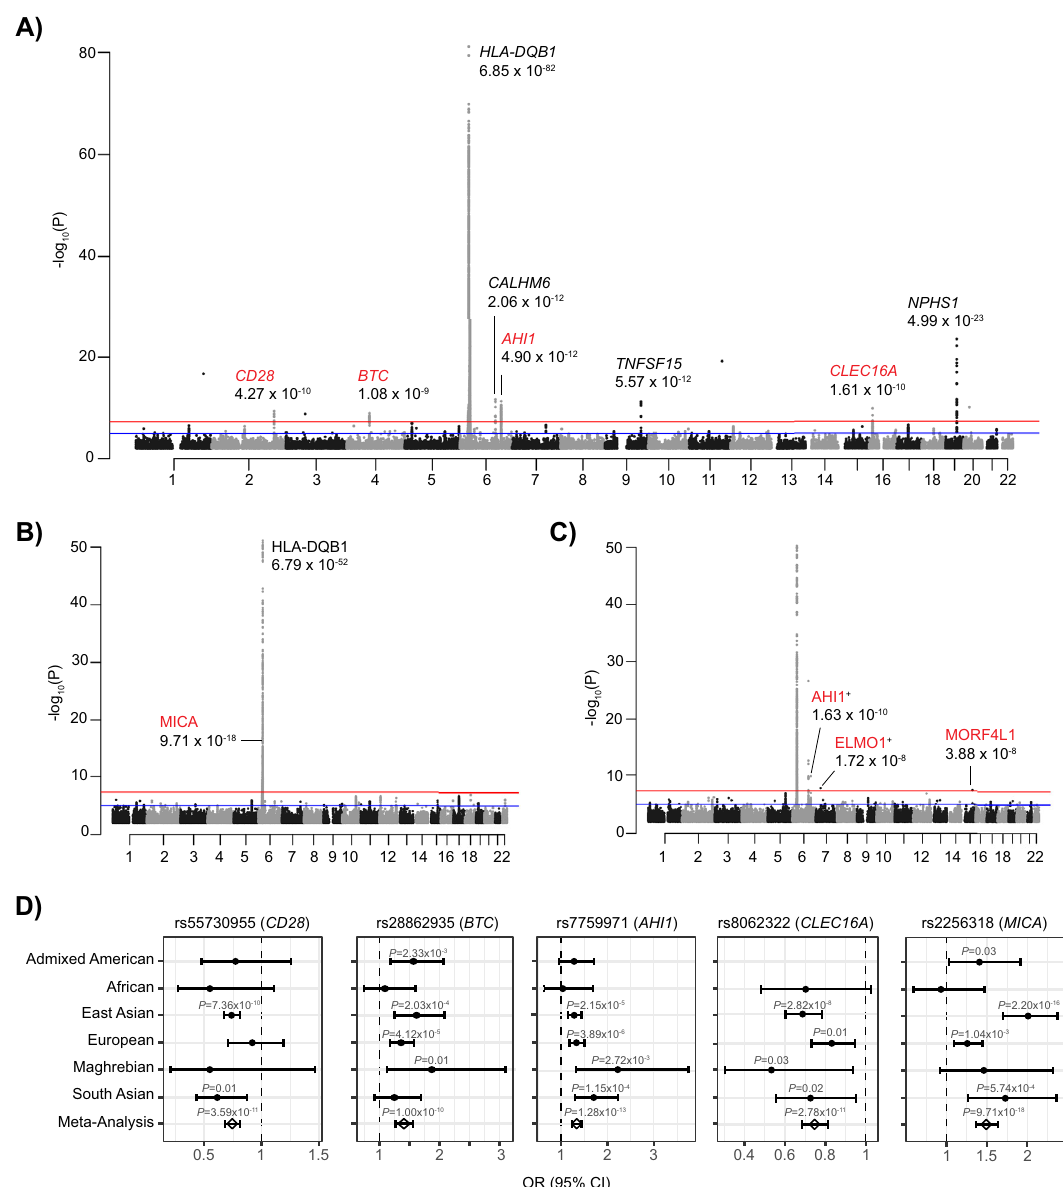
Fig.2|GWASresults. Alllociarelabeledbynearestgenewithnovelassociationsin red. A Multi-populationmeta-analysisof2440casesvs.36,023controls.The P value from test of deviance of full meta-regression model compared to the null model using MR-MEGA. B Multi-population conditional meta-analysis. The P value from multiple linear regression with COJO. C European meta-analysis of 674 cases vs. 6817 controls. Discoveries that included the summary statistics from suggestive SNPsavailablefromDufeketal.areindicatedwith+andonlynovelassociationsare labeled. The P values are from meta-analysis with METAL. D Multi-population and